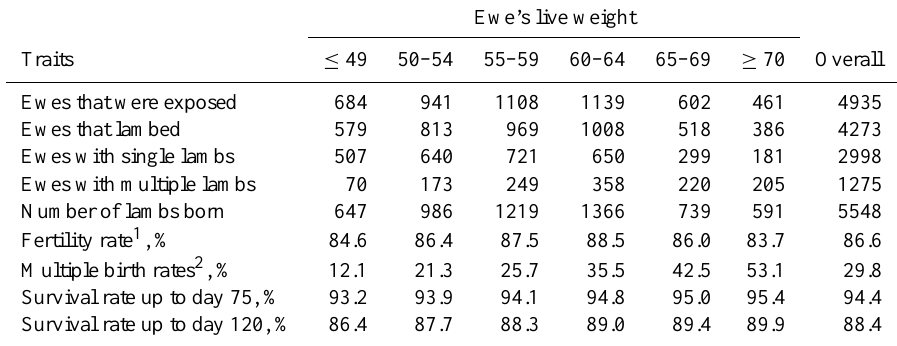
Ewe’s live weight